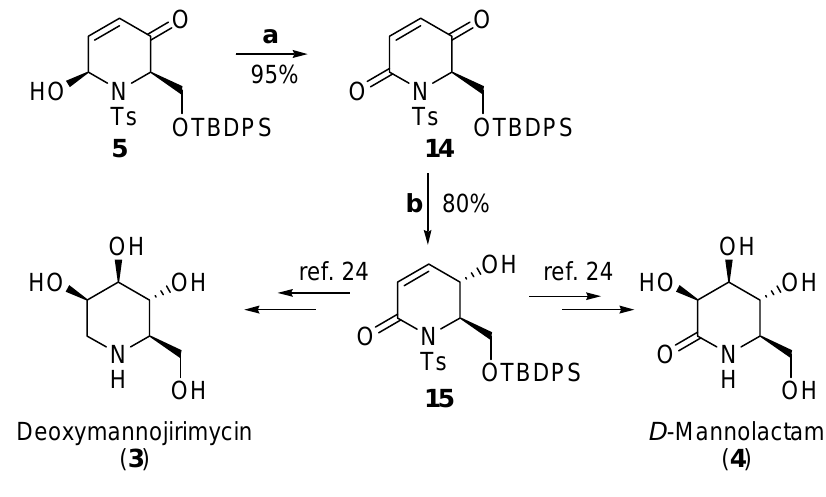
Scheme 3. Synthesis of Deoxymannojirimycin ( 3 ) and D-Mannolactam ( 4